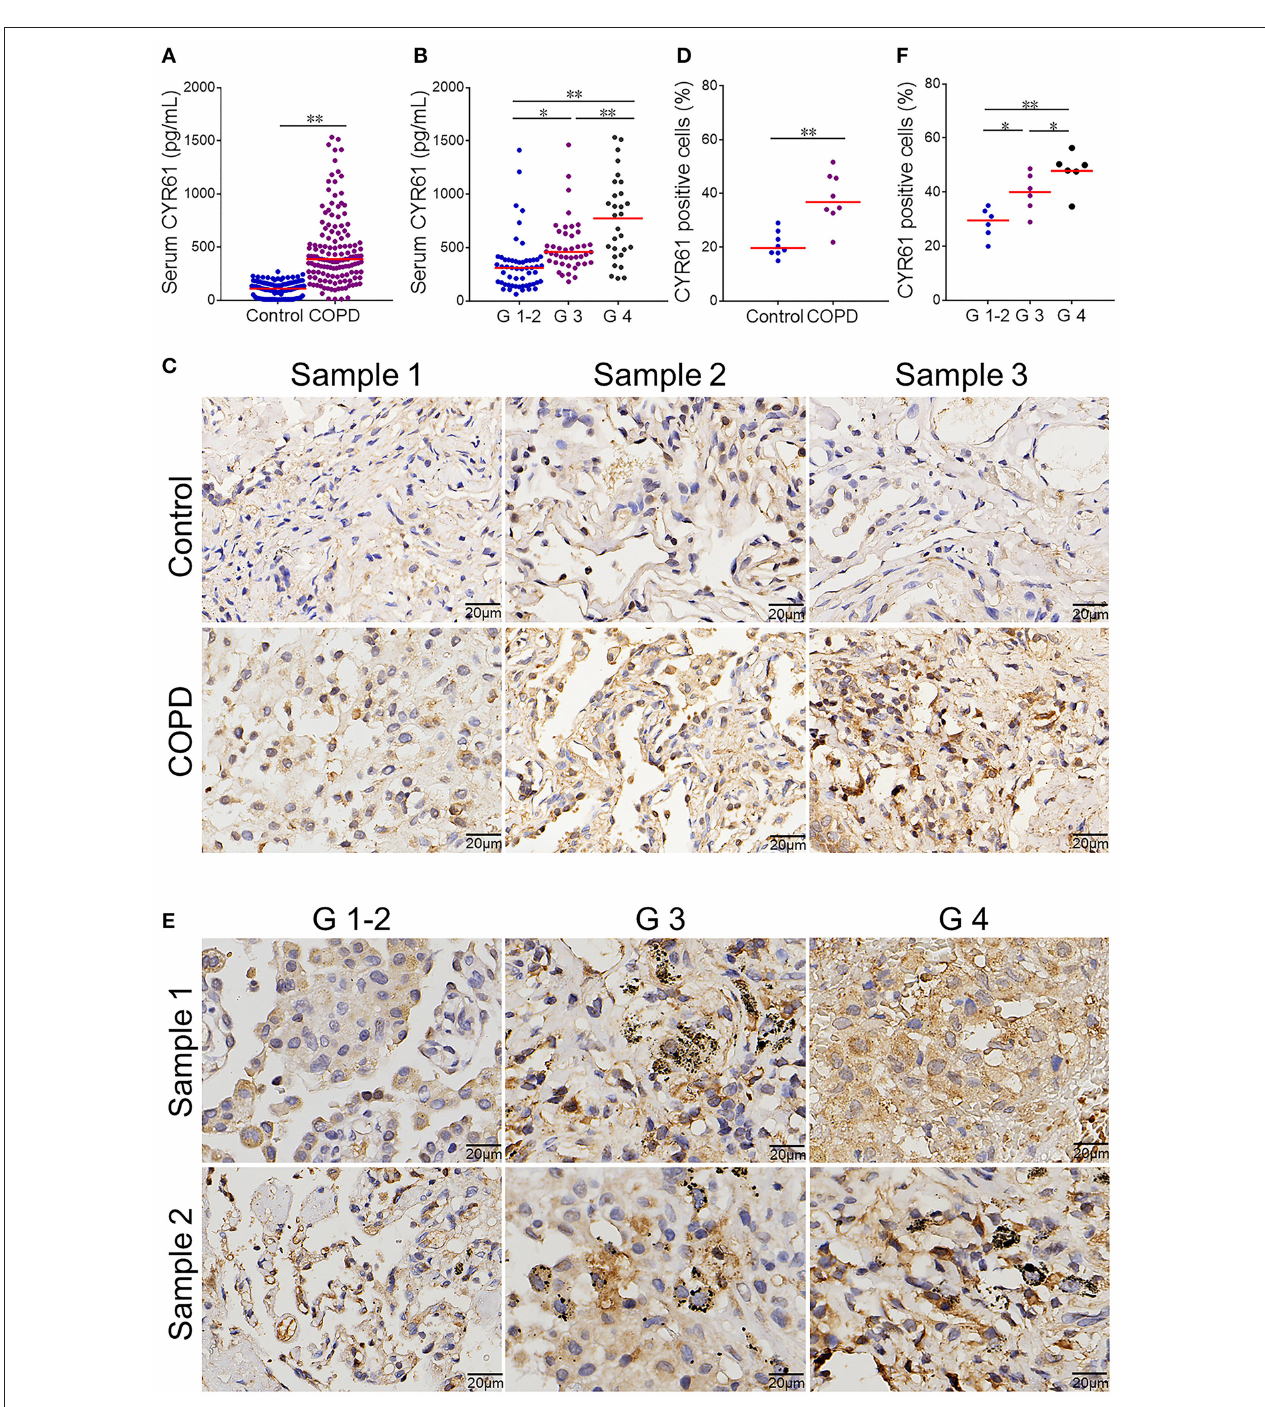
FIGURE 1 | Serum CYR61 level and its association with severity of COPD. Sera were collected from COPD patients and controls. (A,B) Serum CYR61 level was detected using ELISA. (A) Serum CYR61 level was compared between COPD patients and controls. All data were represented as means ± S.E.M. ( N = 150). (B) Serum CYR61 level was compared among different grades of COPD patients. All data were represented as means ± S.E.M. ( N = 69 for G 1-2 patients, N = 48 for G 3 patients, N = 33 for G 4 patients). (C,D) Pulmonary CYR61 expression was compared between COPD patients and controls. (C) Three representative pictures. (D) Quantitative analysis of CYR61-positive cells in COPD patients and controls. (E,F) Pulmonary CYR61 was compared among different grades of COPD patients. (E) Three representative pictures: arrows indicate CYR61-positive cell; (F) Quantitative analysis of CYR61-positive cells in COPD patients with different grades. All data were represented as means ± S.E.M. ( N = 6). * P < 0.05, ** P < 0.01.